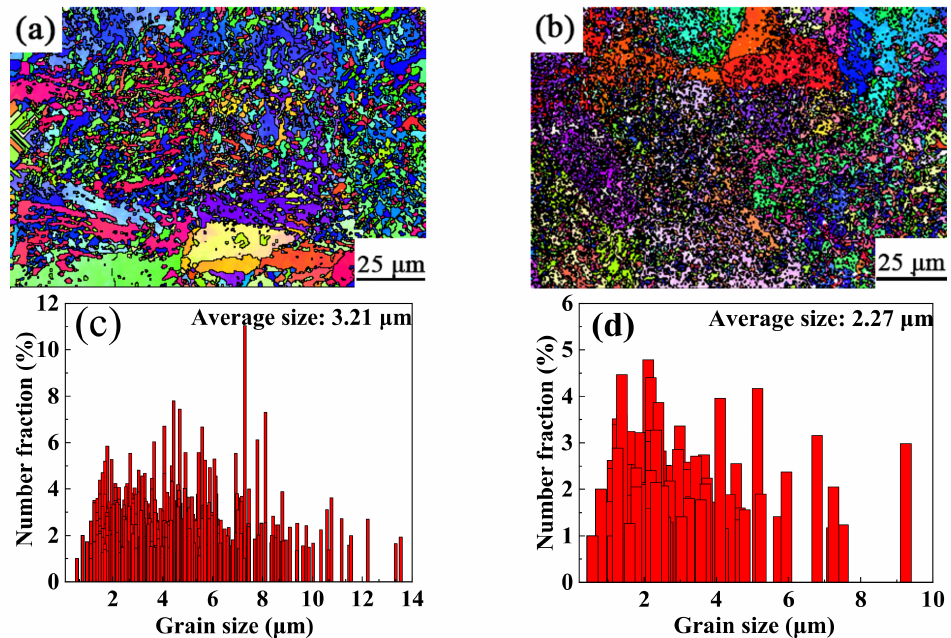
Figure 5. Grain orientation and size distribution of SLM-formed alloys: ( a , c ) TC11 titanium alloy; ( b , d ) GNPs/TC11 titanium matrix composite.